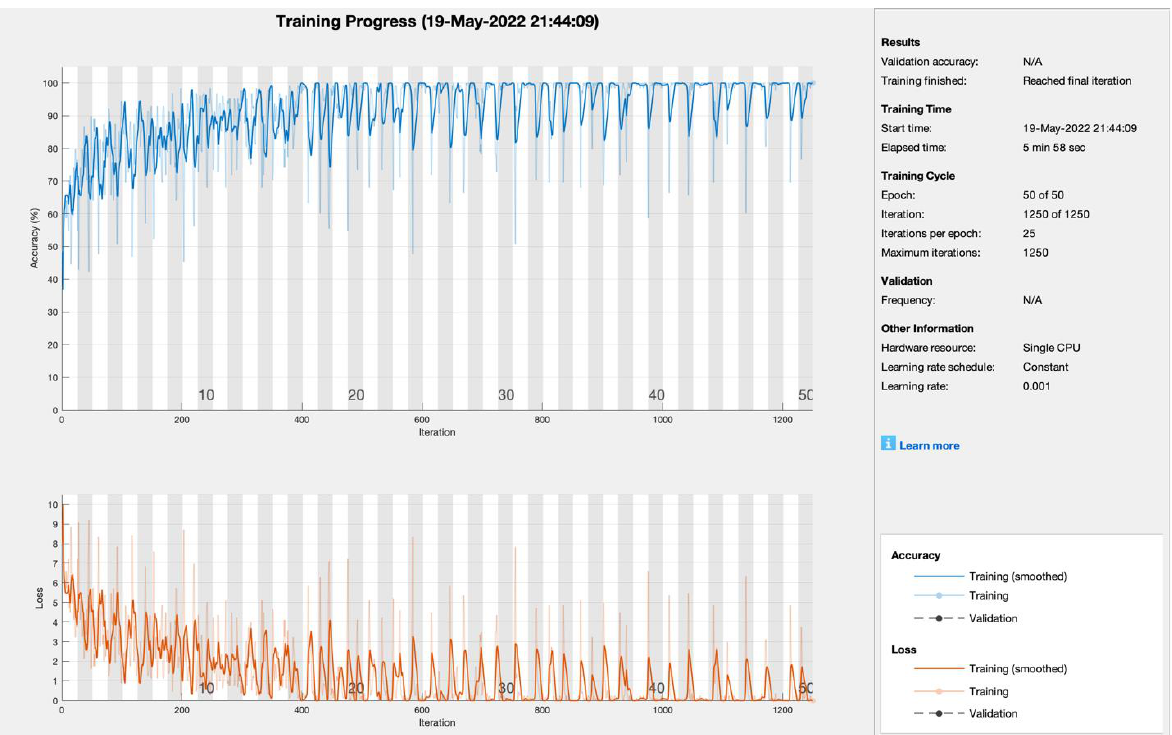
Figure 5. Training progress of RMSProp empowered with blockchain, edge computing, and fog computing.